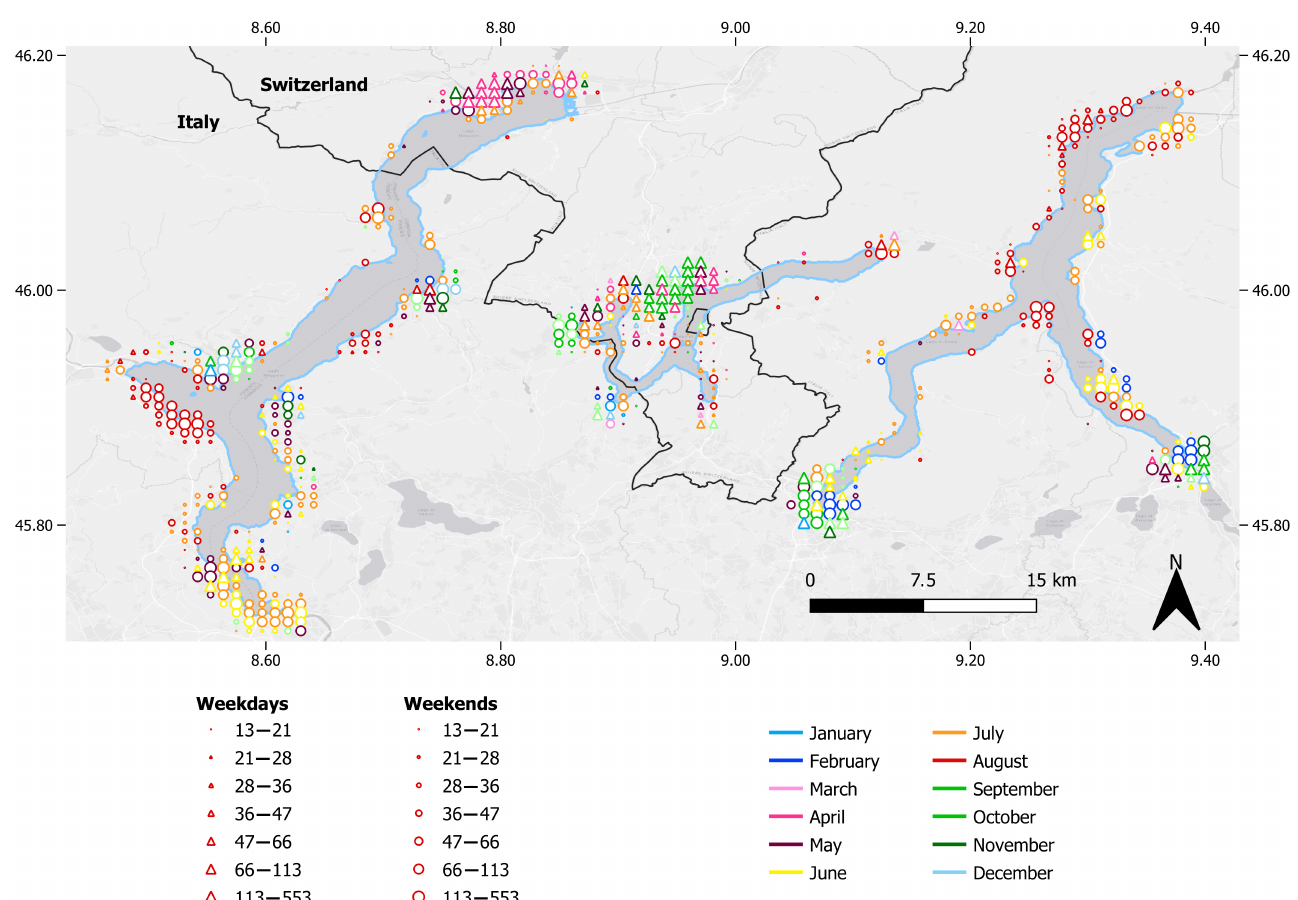
Figure 7. Map of the month of occurrence (marker colour) with distinction between weekdays (triangular marker) and weekends (circular marker) of the maximum values of the Facebook users’ counts registered at each location (Bing tile centre). The marker size is proportional to the value. Missing locations from the Bing tiles grid correspond to tiles with users’ counts lower than 10 that were not available in the Facebook Population Maps